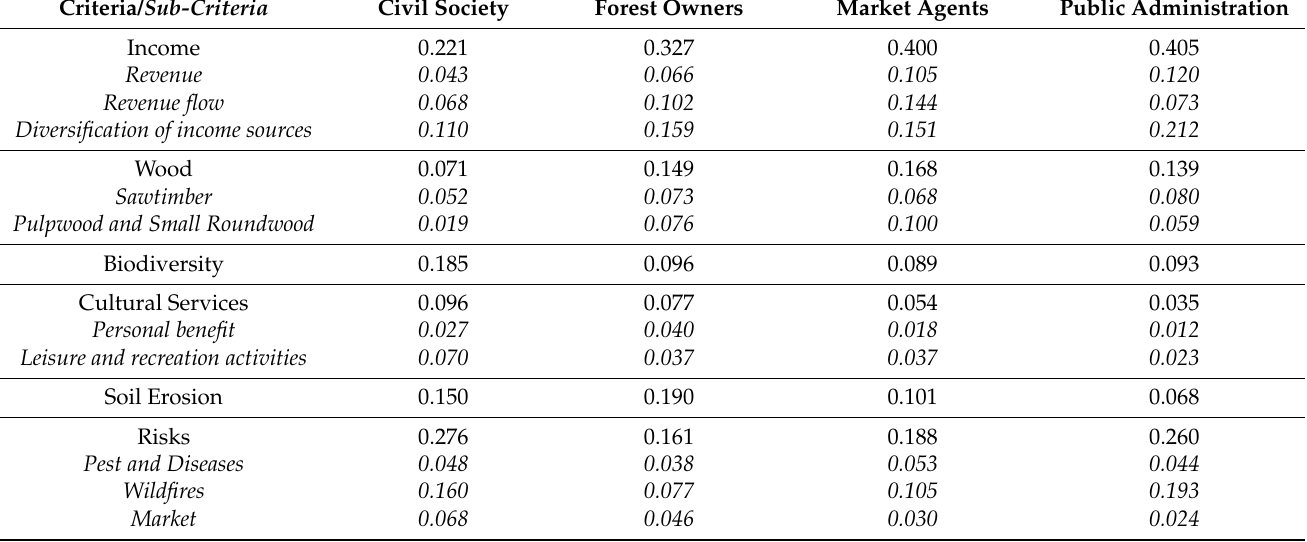
Table 1. Criteria and sub-criteria weights of the MCDA model by interest group [30]. In each group, criteria weights sum to 1. At the sub-criterion level, criteria weights are shown as distributed to the sub-criteria under each criterion (e.g., the sub-criteria weights under a criterion sum to the criterion weight). Lowest level criteria evaluate the attributes of the alternatives. The priority score for an alternative (a management unit) is calculated as the sum of products of the lowest level criterion weights and the utility scores of each attribute for the alternative (note that biodiversity and soil erosion are also lowest level